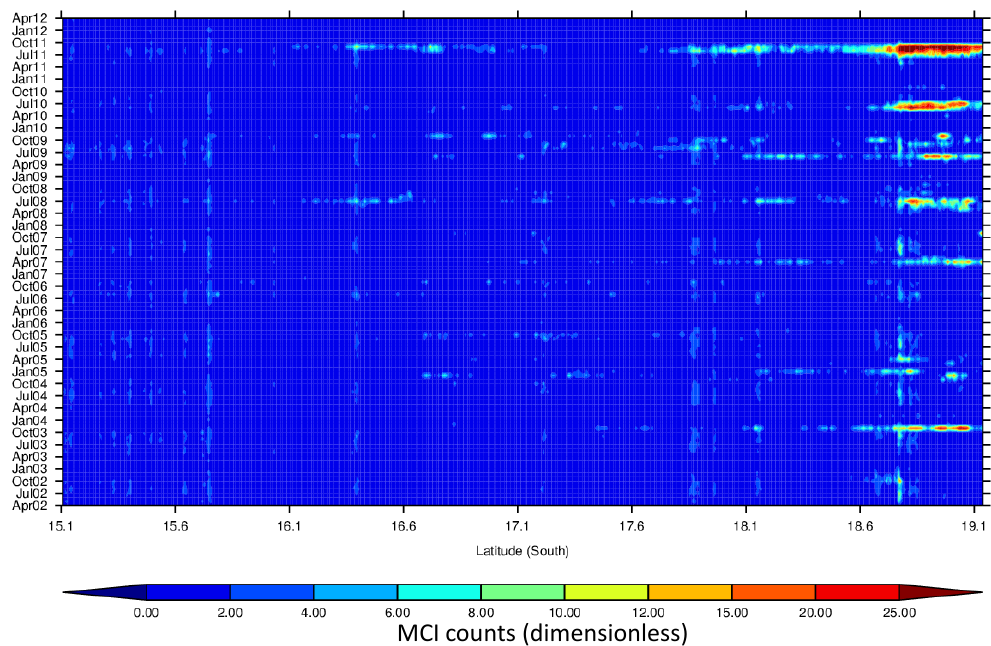
Figure 18. Latitude-time plot of MCI counts for the GBRW cluster. The surface bloom event of 30 July 2008 (Figure 2) can be seen (18.6–19.1°S).